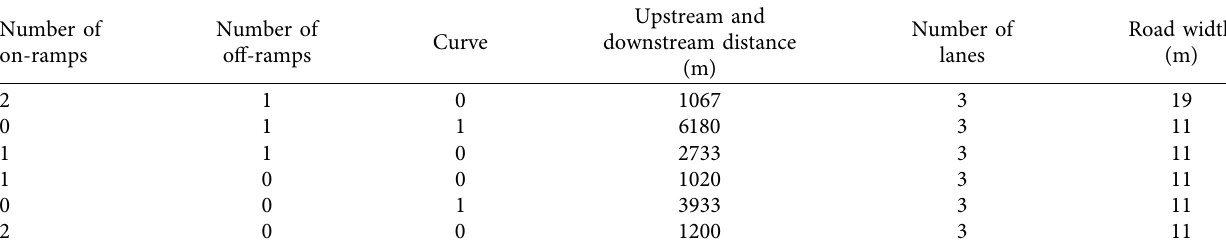
Table 4: Examples of road features and their